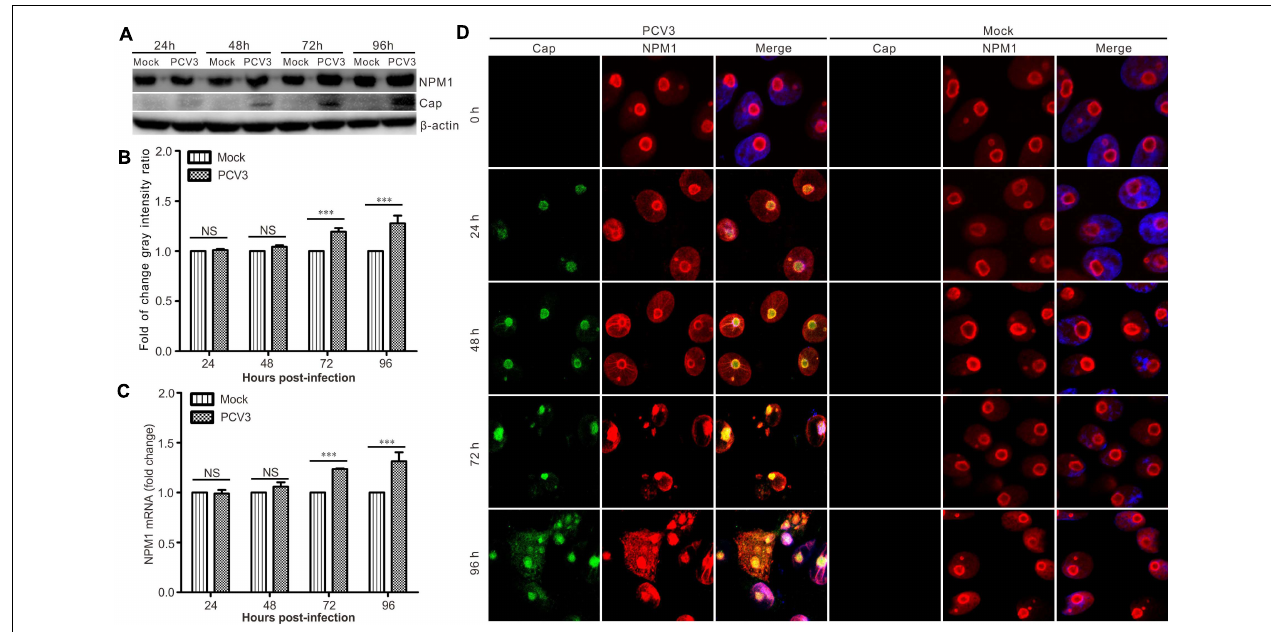
FIGURE 5 | PCV3 increased the overall abundance of NPM1 in infected PK15 cells. (A) PK15 cells were infected with PCV3 and harvested at 24, 48, 72, and 96 h post-infection. The cell lysates were subjected to western blotting to examine the levels of Cap and NPM1 protein. β -actin was used as an internal control. (B) Graph showing the levels of NPM1 normalized against β -actin. The relative gray intensity was quantified using ImageJ. Each experiment was independently done three times. Data represent by the mean ± standard deviation (SD) (*** P < 0.001; NS, not significant). (C) Real-time quantitative PCR was used to calculate the expression of NPM1 mRNA in PCV3-infected cells at 24, 48, 72, and 96 hpi. Expression was normalized to the GAPDH mRNA level. The relative expression was analyzed using GraphPad Prism. Each experiment was independently done three times. Data represent the mean ± SD (* P < 0.05; ** P < 0.01; *** P < 0.01; NS, not significant). (D) PK15 cells were infected with PCV3, fixed, and subjected to immunofluorescence assay at 0, 24, 48, 72, and 96 hpi, respectively. Immunofluorescence signals revealed the expression of Cap (green) and NPM1 protein (red). DAPI was used to stain cell nuclei